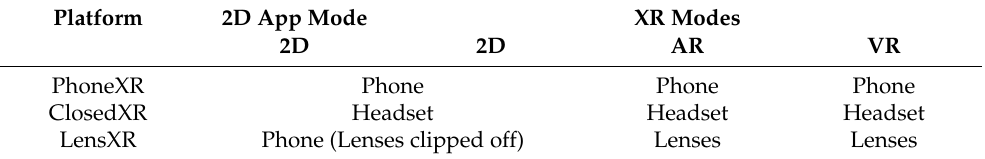
Table 1. The three tested platforms for multi-mode and multitasking XR user experience. Platform 2D App Mode XR Modes 2D 2D AR VR PhoneXR Phone Phone Phone ClosedXR Headset Headset Headset LensXR Phone (Lenses clipped off) Lenses